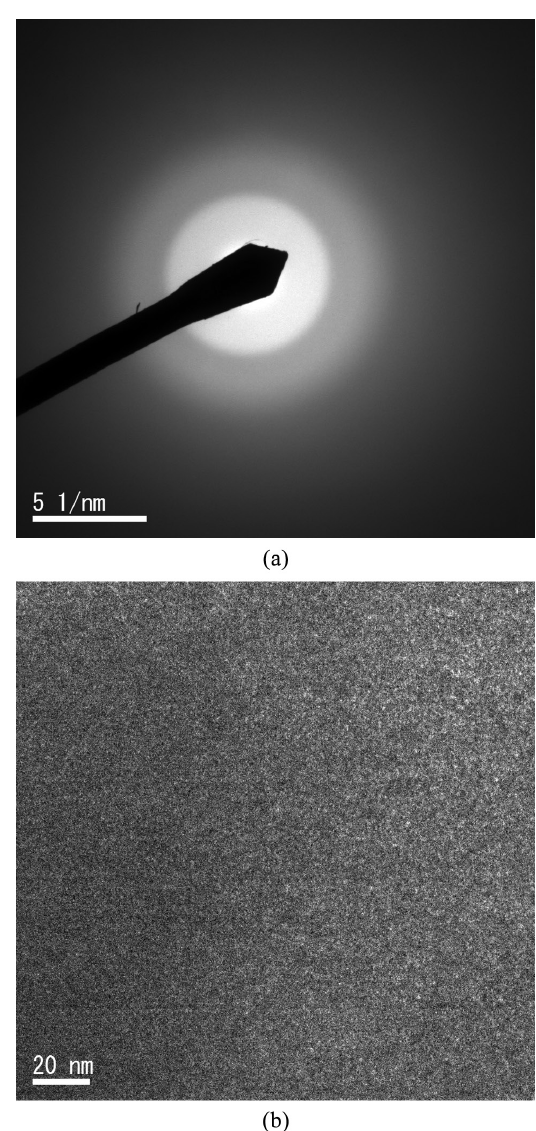
Figure 3. TEM images of Fe halo; (b) Dark-field